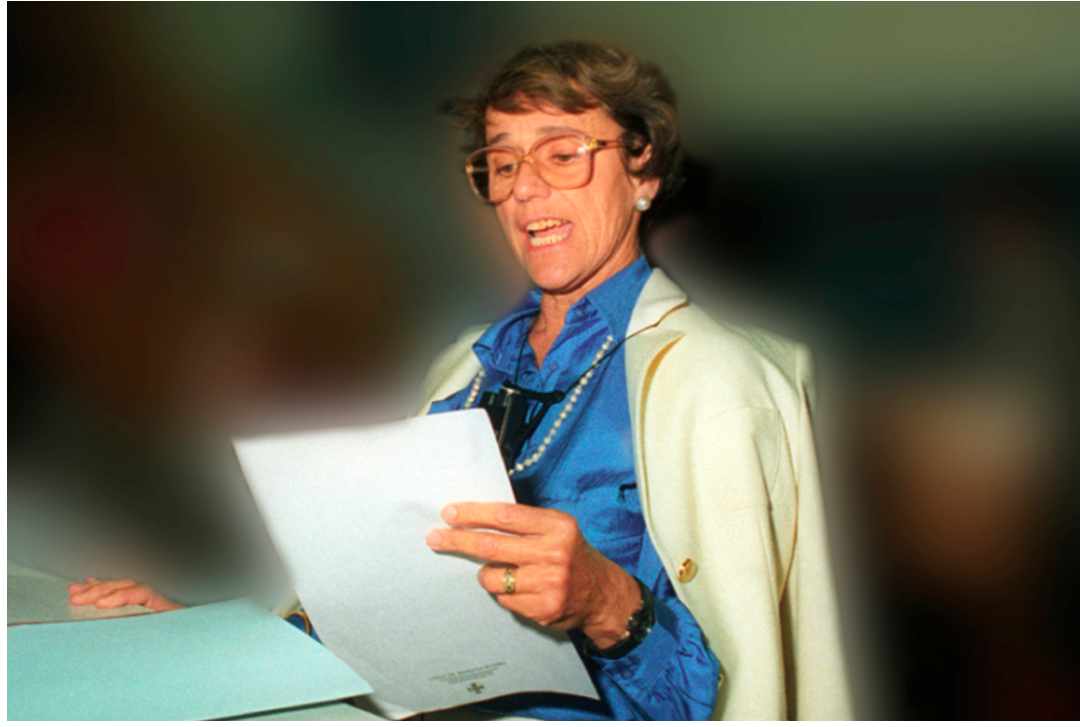
screening for congenital hypothyroidism and gave her best to enhance the health of children with endocrine diseases. She has been a distinguished pioneer and role model for many, especially female pediatric endocrinologists world-wide and we will certainly miss her.